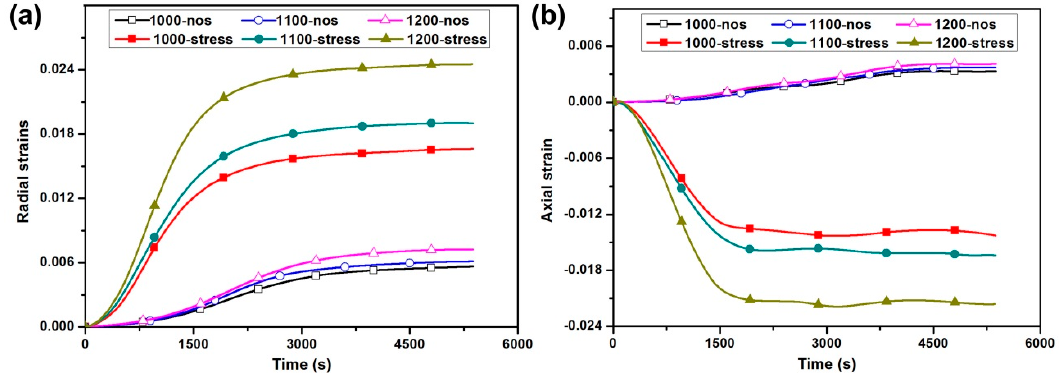
Figure 5. The radial and axial strains of the different specimens during the bainitic transformation at 330 °C: ( a ) radial strains and ( b ) axial strains.